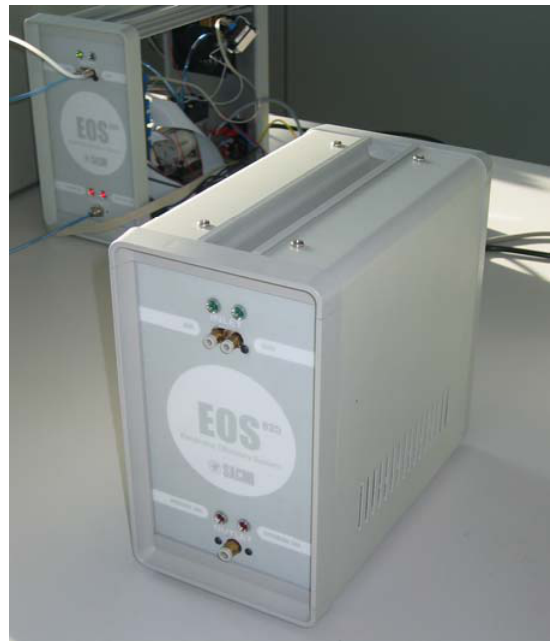
Figure 1. The EOS 835 electronic nose.